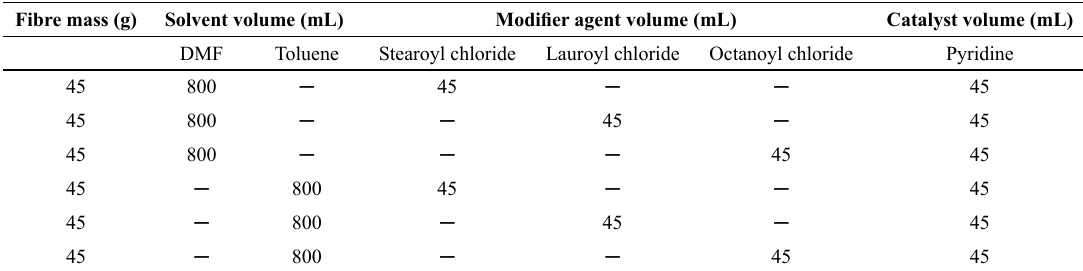
Table 1. Reagents amounts used in esterification